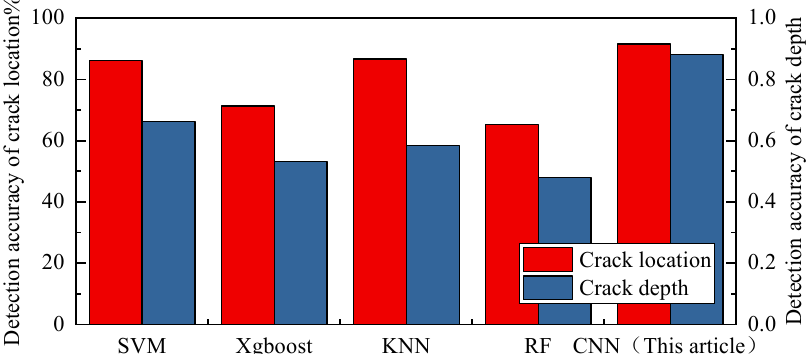
Figure 14. Prediction accuracy of different deep learning models.